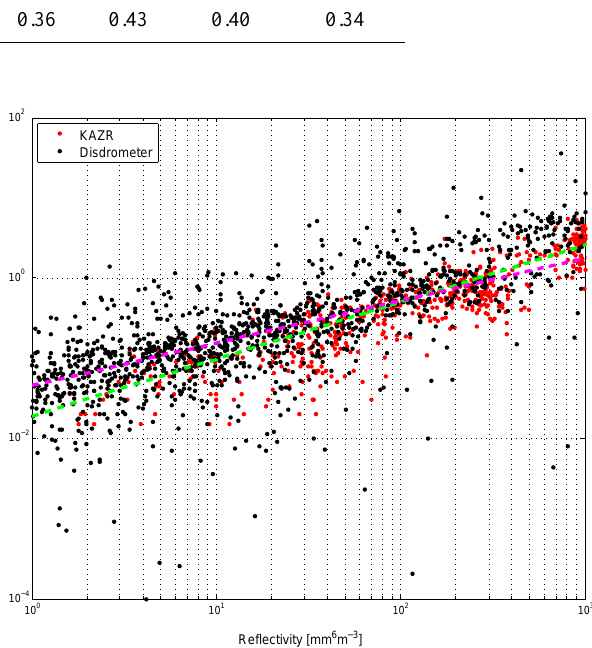
Figure 6. Comparison of Z e – R relationships based on the KAZR reflectivity, and computed reflectivity’s at the Ka-band using dis- drometer data. The green and magenta dashed lines indicate power laws (RR = aZ b , where a and b are coefficient and exponent) fitted to the KAZR and disdrometer data, respectively. For the green line, a = 0 . 0112 and b = 0 . 8469. For the magenta line are a = 0 . 0267 and b = 0 .